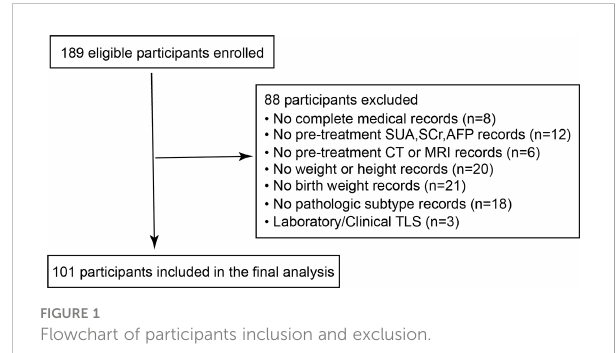
FIGURE 1 Flowchart of participants inclusion and